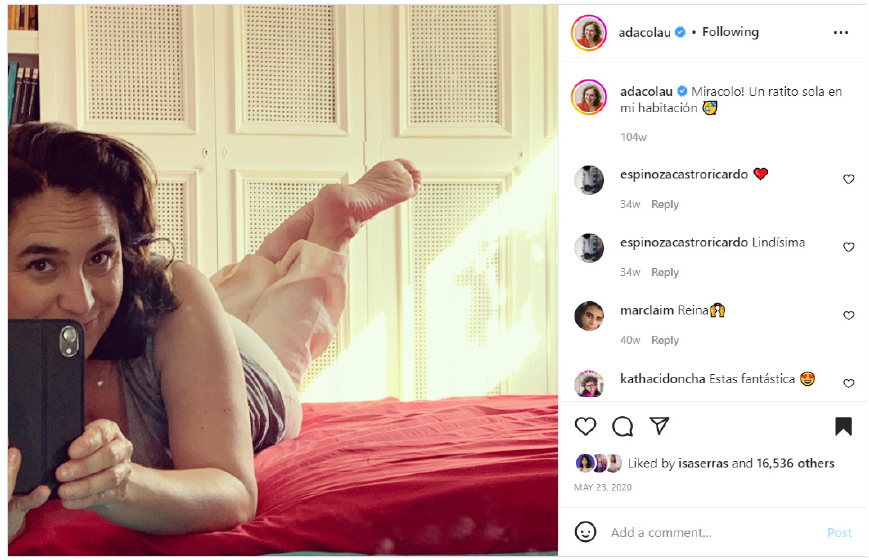
Figure 2. Colau lying in bed on May 23,